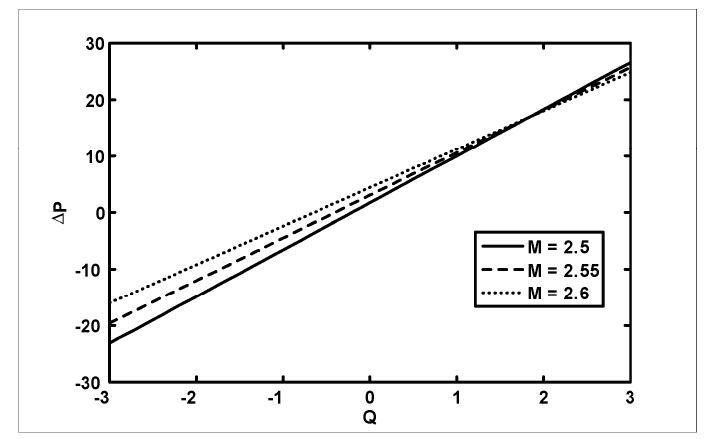
∆ p with Q for di ff erent values of M at r Δ with Q for different values of M at